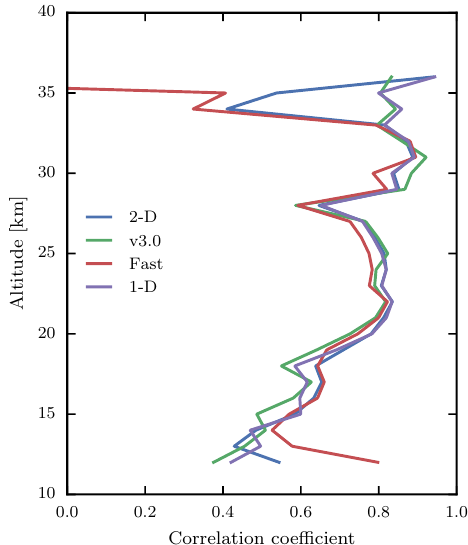
Figure 9. Correlation between various OSIRIS NO 2 products and the balloon validation